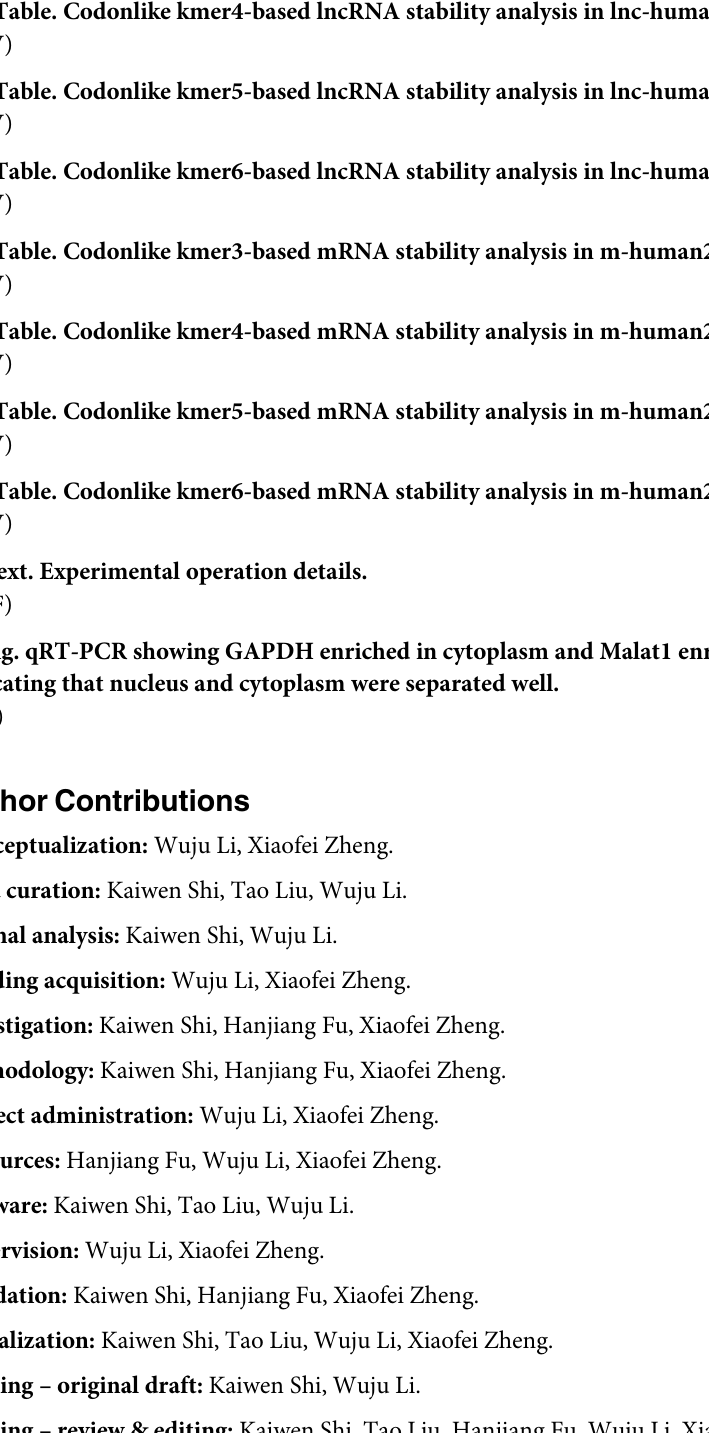
S1 Text. Experimental operation details. S1 Fig. qRT-PCR showing GAPDH enriched in cytoplasm and Malat1 enriched in nucleus, indicating that nucleus and cytoplasm were separated